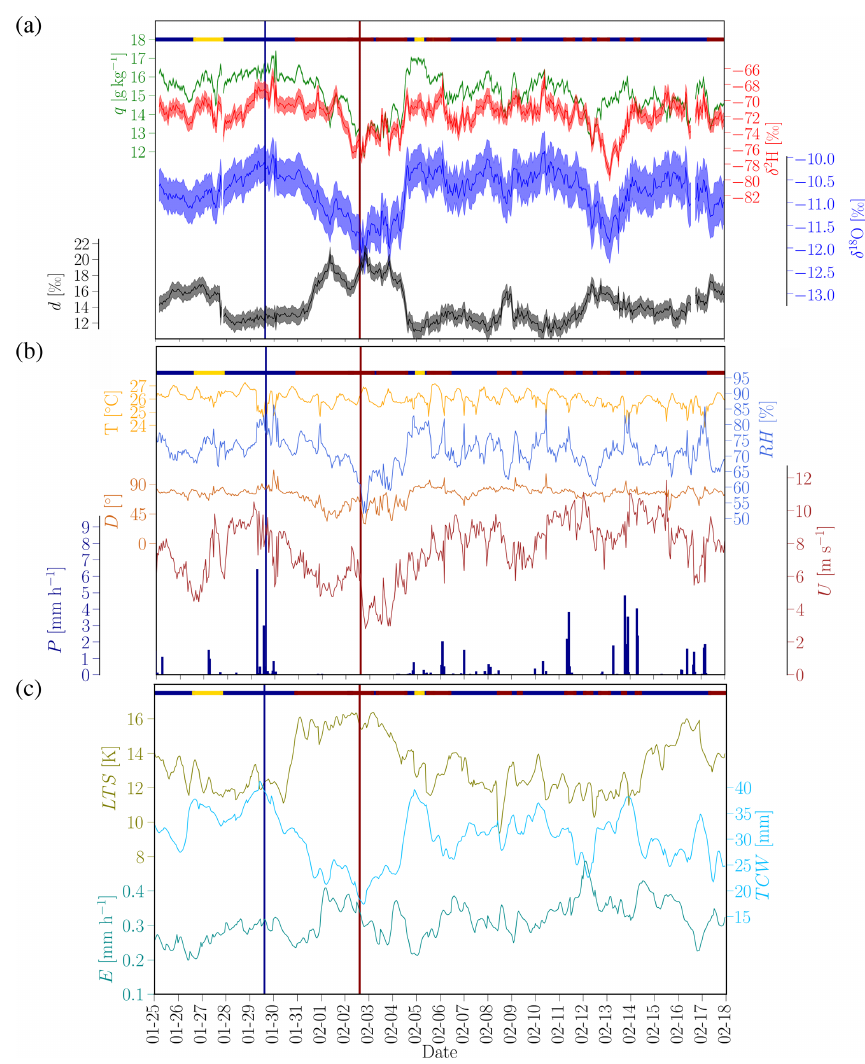
Figure 8. Hourly stable-water-vapour-isotope measurements in ambient air (a) , meteorological variables from the BCO (b) , and ERA-5 data averaged over a box with a horizontal extent of 13–15 ◦ N and 58–60 ◦ W (c) from 25 January to 17 February 2018. T is the air temperature, RH the relative humidity, U the wind speed, D the wind direction, P the rainfall rate, TCW the total column water, E the surface evaporation (positive upward) and LTS the lower-tropospheric stability (LTS = θ 700hPa − θ 1000hPa , with potential temperature θ in K). The coloured bars at the top indicate the regime classification as in Fig.